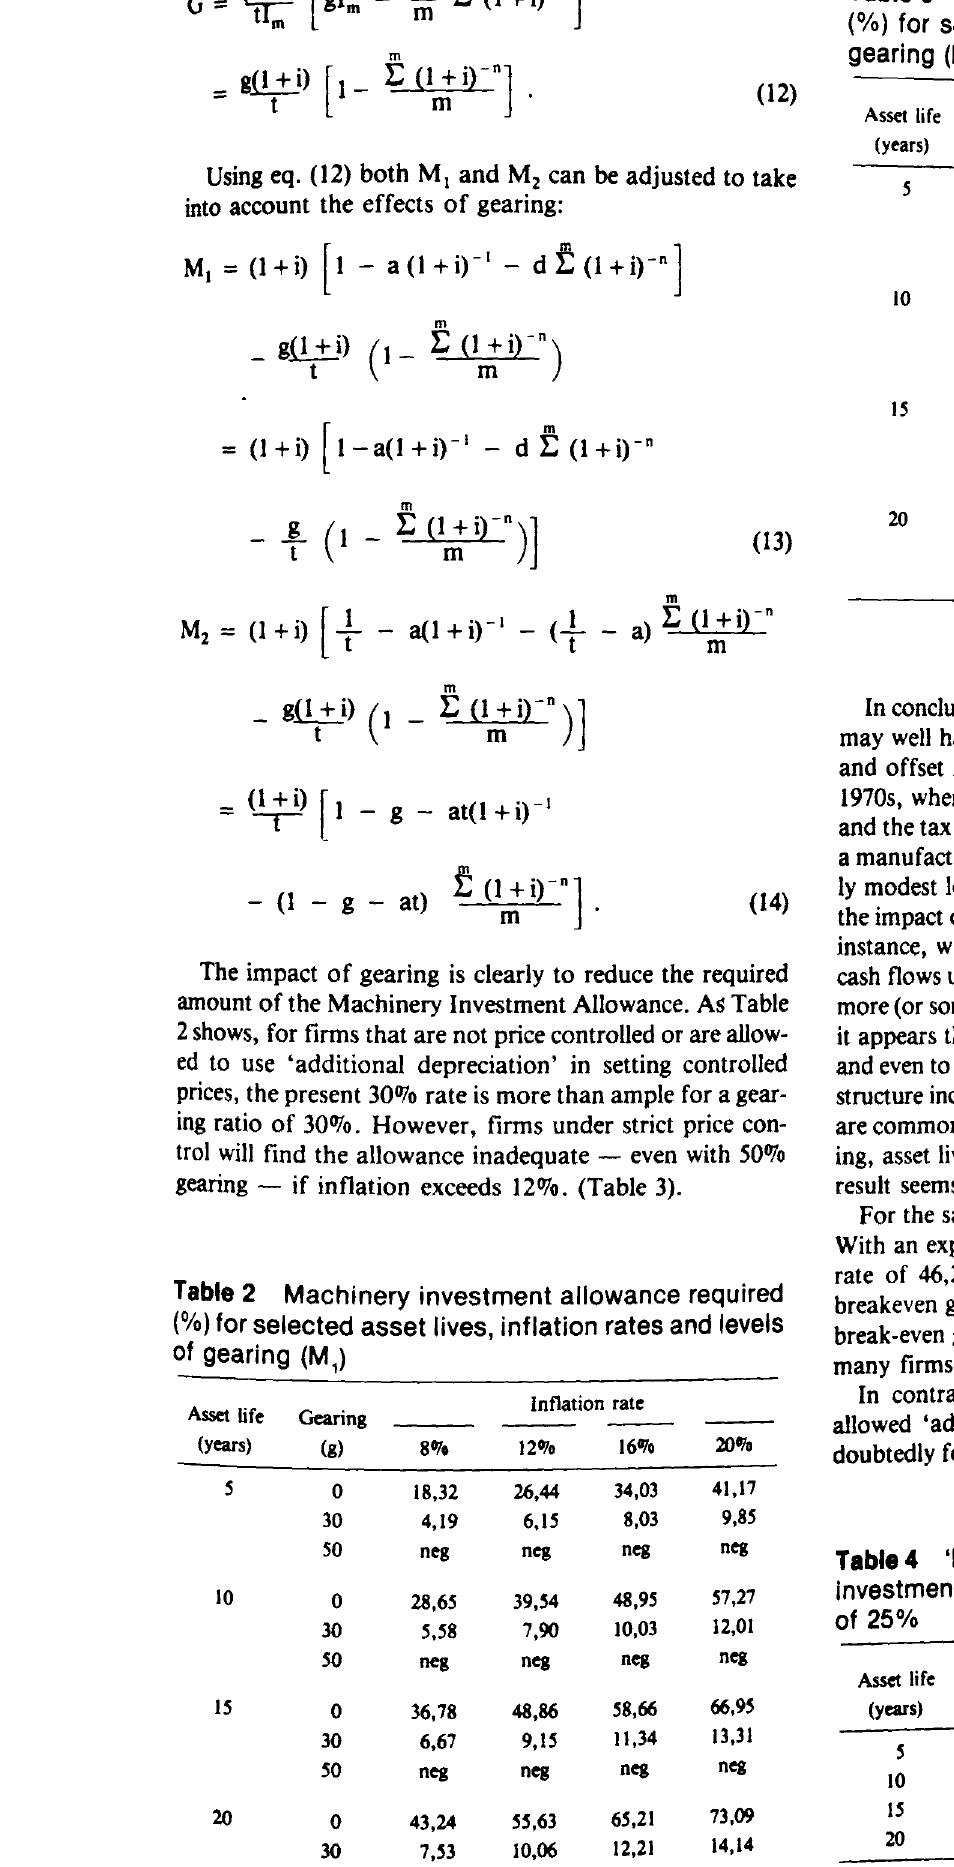
Table 3 Machinery investment allowance required (%) for selected lives, inflation rates and levels of gearing (M